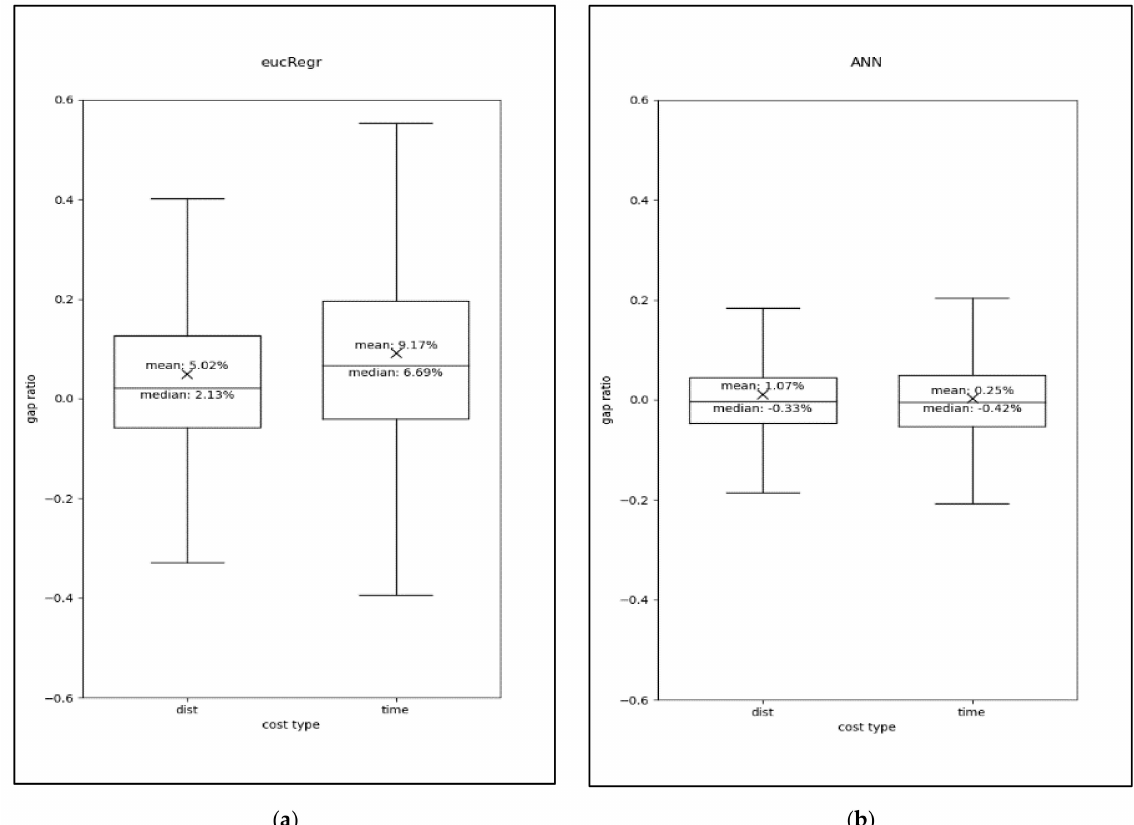
Figure 5. Percentage error of estimation in box whisker plot. ( a ) Regression model. ( b ) Artificial neural network